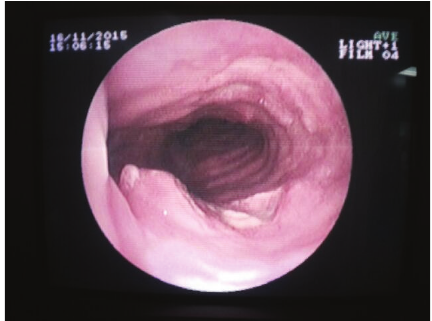
Figure 2: Snapshot from bronchoscopy depicting fracture of the first tracheal